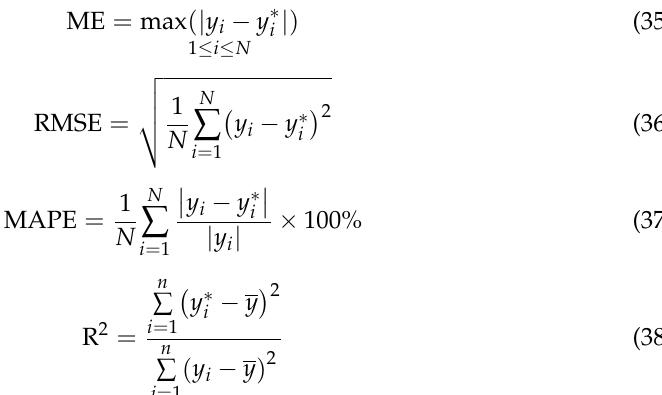
Figure 6. Layout of pendulum monitoring instruments. Figure 7. Evolution of the water level and the horizontal displacement at three measuring points. In this study, the displacement data of the training set were first denoised using the WD method with Sym4 as the wavelet basis function. The variable threshold (Equation (11)) and the Garrot threshold function method (Equation (12)) were used, and the num- ber of decomposition layers was set to 3. Subsequently, ISSA, as introduced in Section 5, 2010/7/1 2011/7/1 2012/7/1 2013/7/1 2014/7/1 2015/7/1 2016/7/1 2017/7/1 2018/7/1 2019/7/1 2020/7/1114011701200 12301260 W a t e r L e v e l ( m ) Water Level